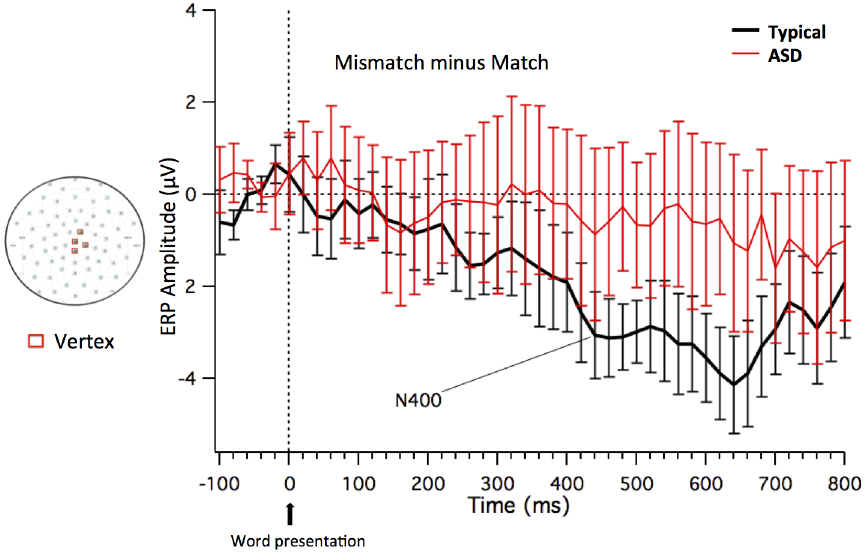
Fig 8. Word subtraction ERP waveforms. Subtraction ERP waveforms (Mismatch minus Match – including standard error bars) time-locked to Word 1 for the two groups (Neurotypical and ASD children) in the mean channel relative to the vertex sites included in the array. The sites that were used to create the Vertex array are displayed in the topographical map (in